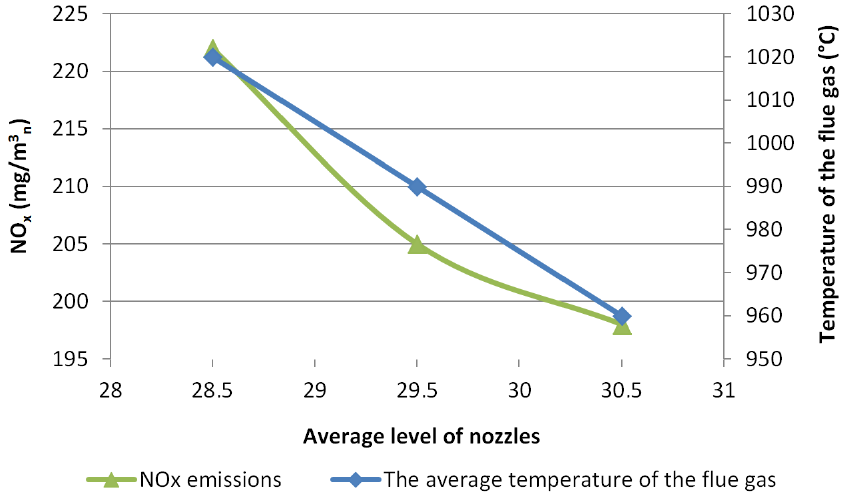
Figure 15. The average flue gas temperature (°C) and NO x emissions converted to 6% of O 2 in dry flue gas (mg/m 3n ) as a function of the average nozzle height level (m).